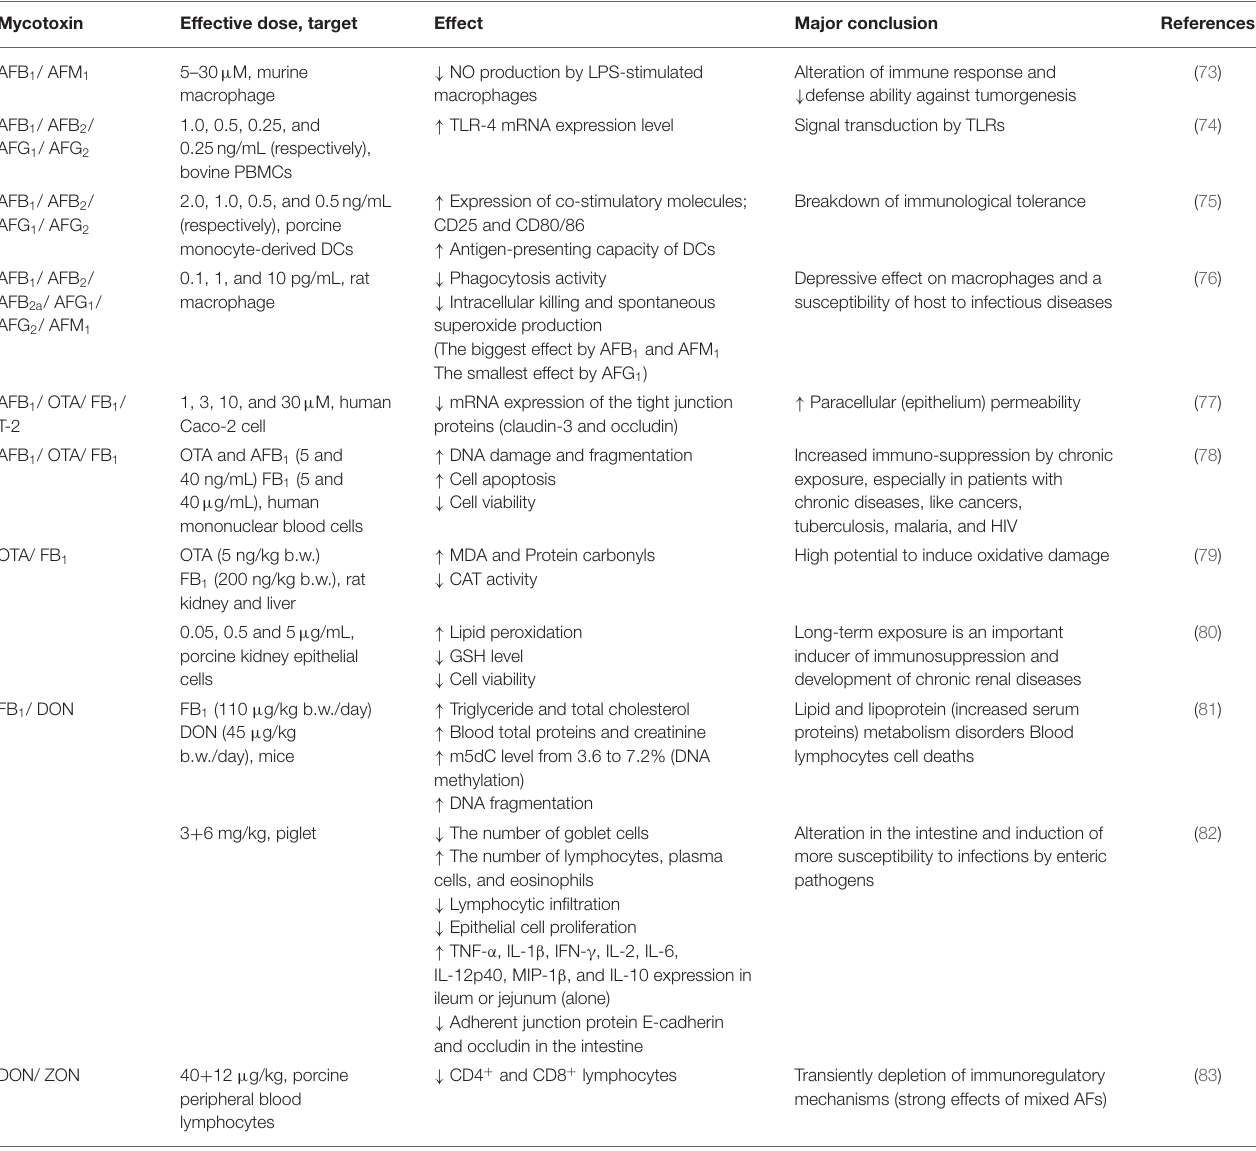
TABLE 3 | Examples of combined mycotoxins effects disturbing metabolic and immune reactions (focusing on low